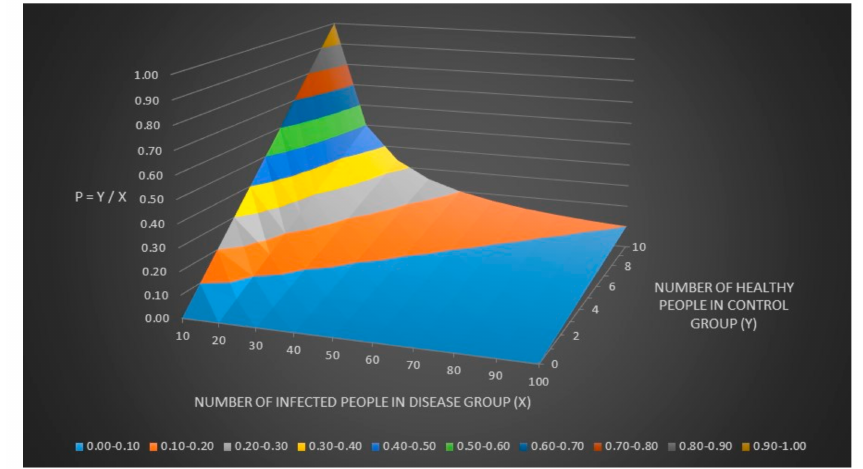
Figure 3. The relationship between y, x and p.